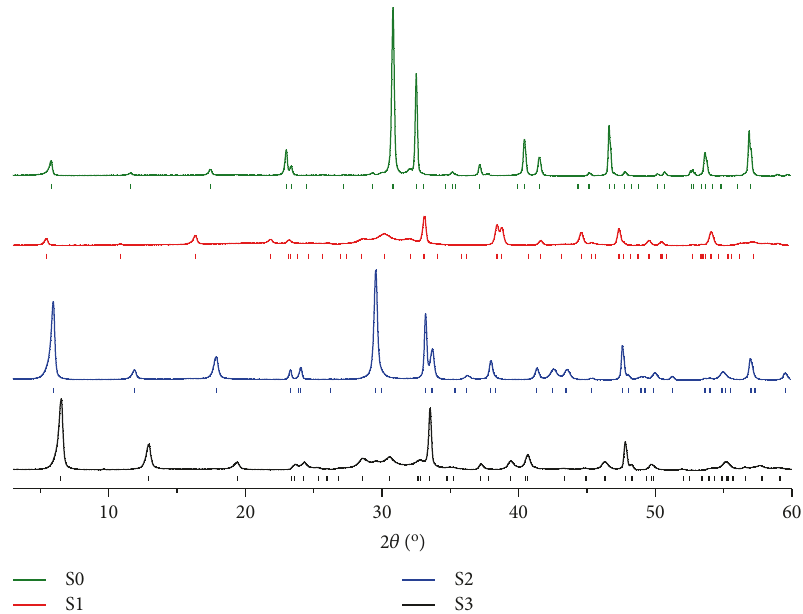
Figure 1: X-ray powder di ff raction patterns of the initial (S0) and protonated (S1, S2, and S3) Rb